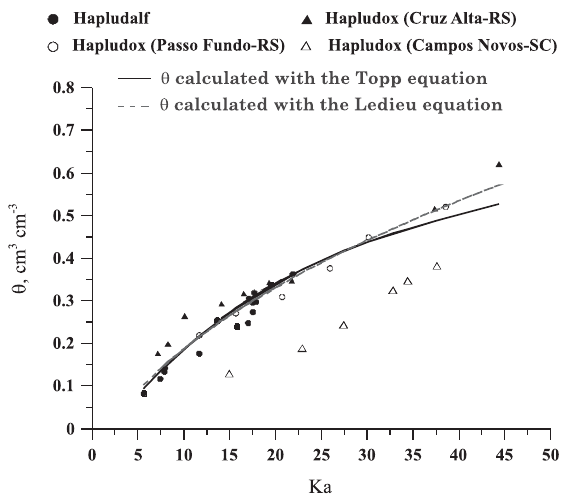
Figure 2. Relation between the dielectric constant (Ka) measured with the TDR-100 and the volumetric soil moisture ( θθθθθ ) determined and calculated by the Topp and Ledieu